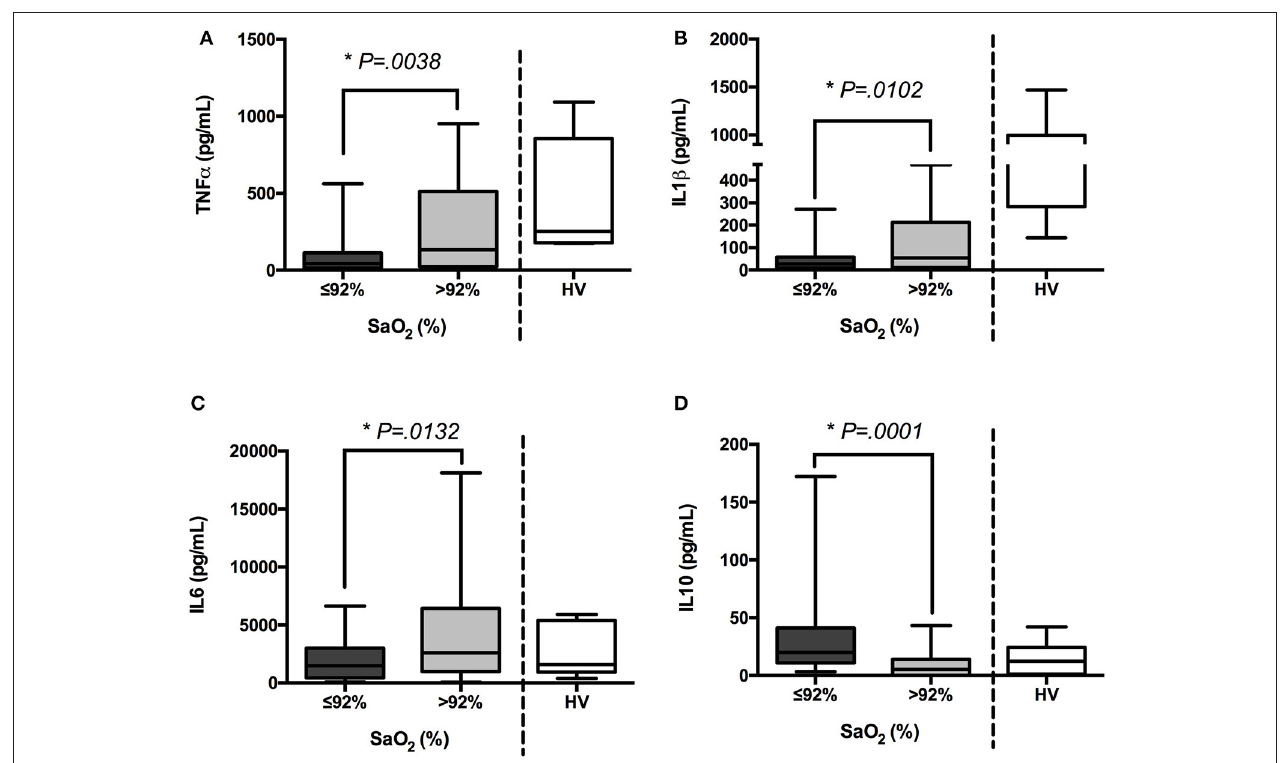
FIGURE 3 | Inflammatory response is donwregulated in patients with sepsis who exhibited low oxygen saturation. TNF α (A) , IL-1 β (B) , IL-6 (C), and IL10 (D) production (pg/mL) after 3h (TNF α , IL-6 and IL10) or 6h (IL1 β ) of ex vivo LPS stimulation (5ng/mL) in whole blood samples from patients with sepsis ( n = 85) and healthy volunteers (HV, n = 15), were quantified by cytometric bead array (CBA) and FACS. Cytokine quantifications in patients classified according to their oxygen saturation and HV are shown. * p < 0.05 using a Student’s t